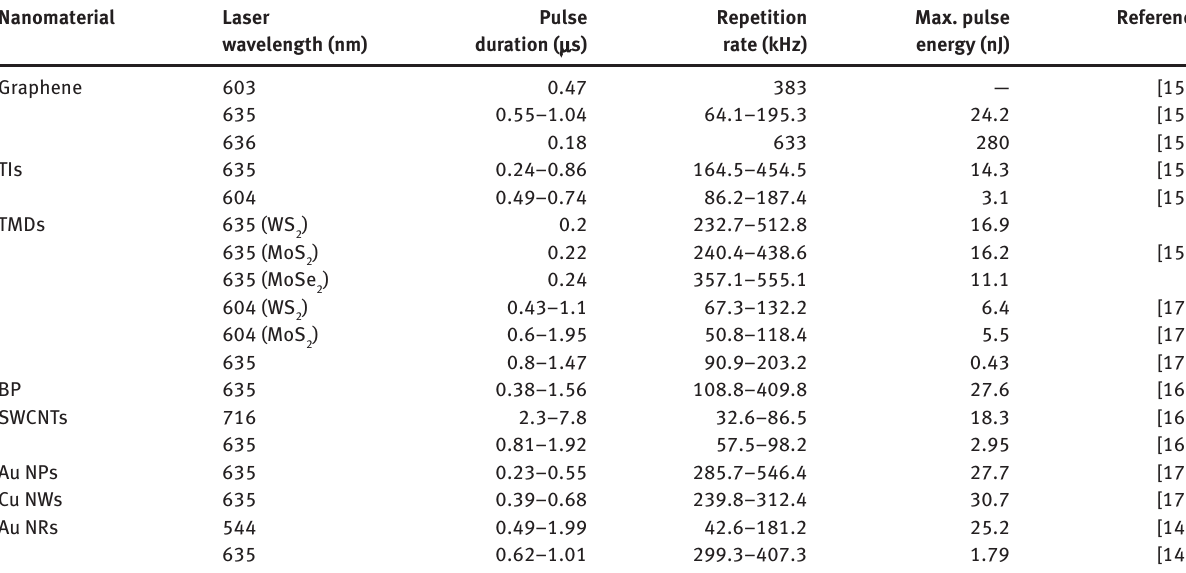
Table 1: Summary of Q-switched fiber lasers based on nanomaterial